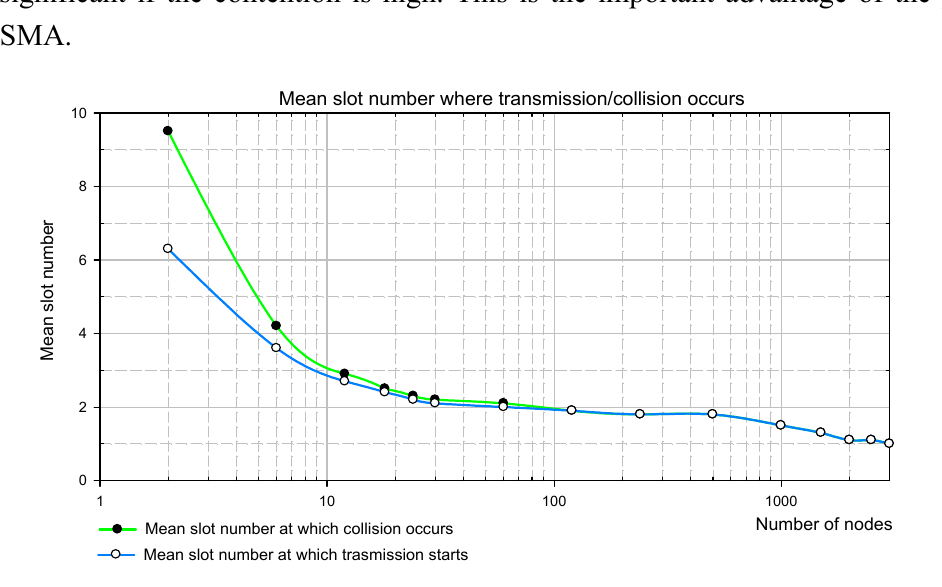
Figure 7. Mean slot number, at which the transmisson )( nd